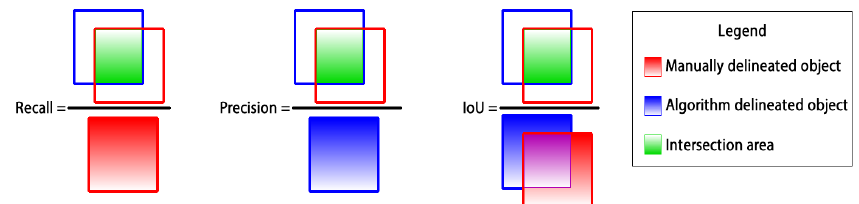
Figure 8. The relation between the bounding box from the algorithm-delineated object and the manually delineated object (evaluation object) to obtain the Recall , Precision , and IoU